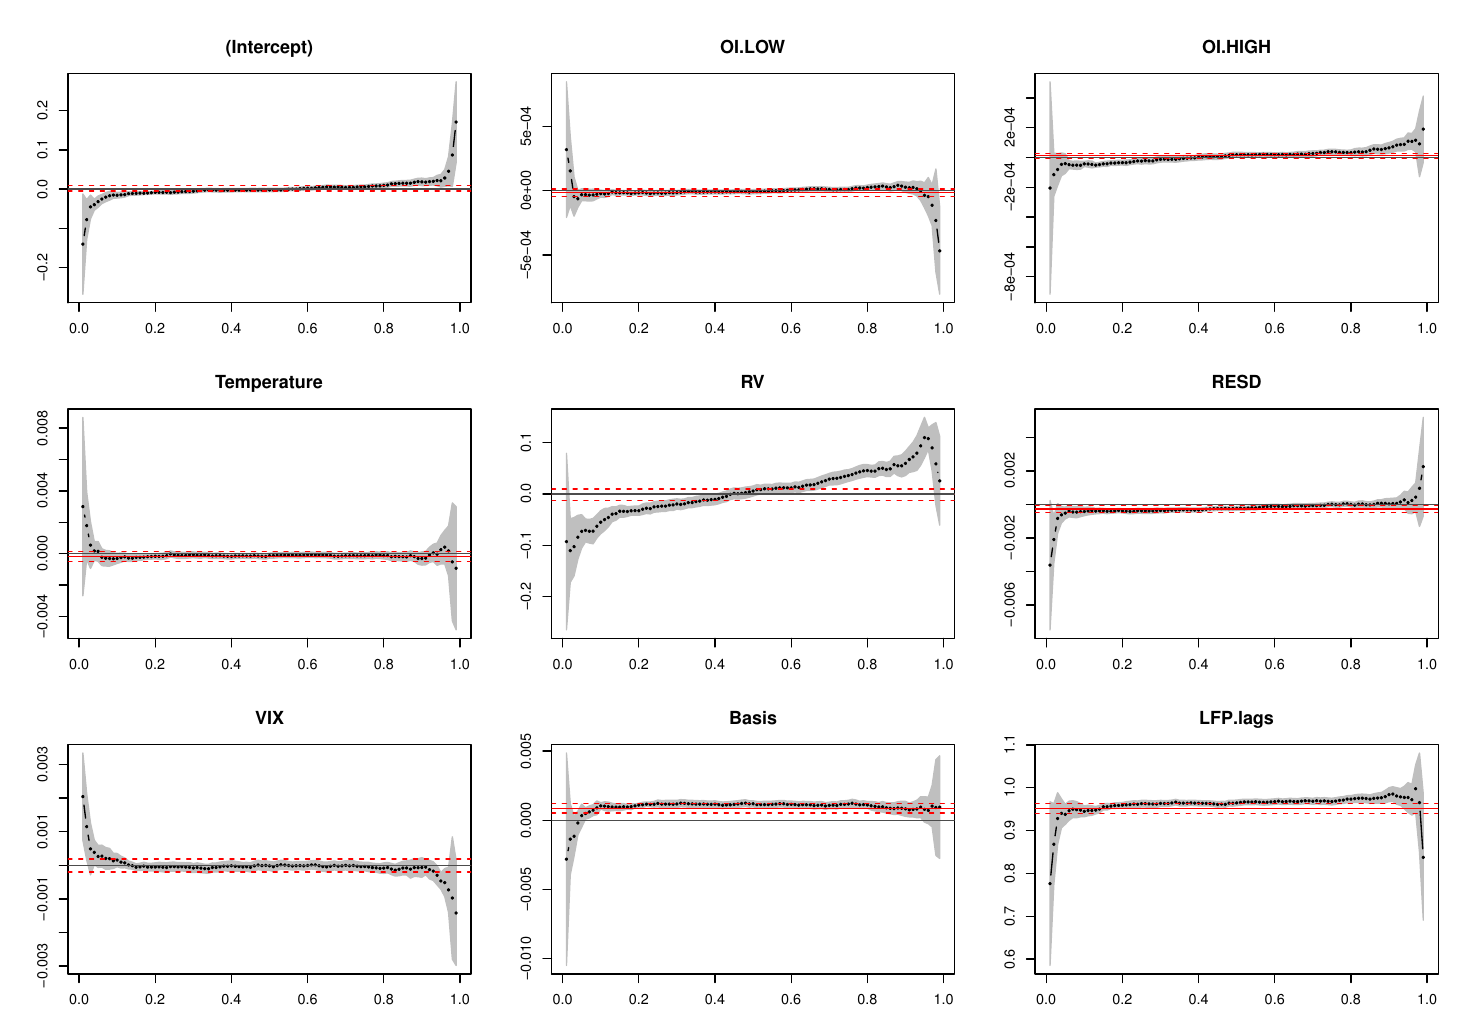
Figure 5. Quantile regression coefficients plotted for various quantiles with the logarithmic forward premium as the dependent